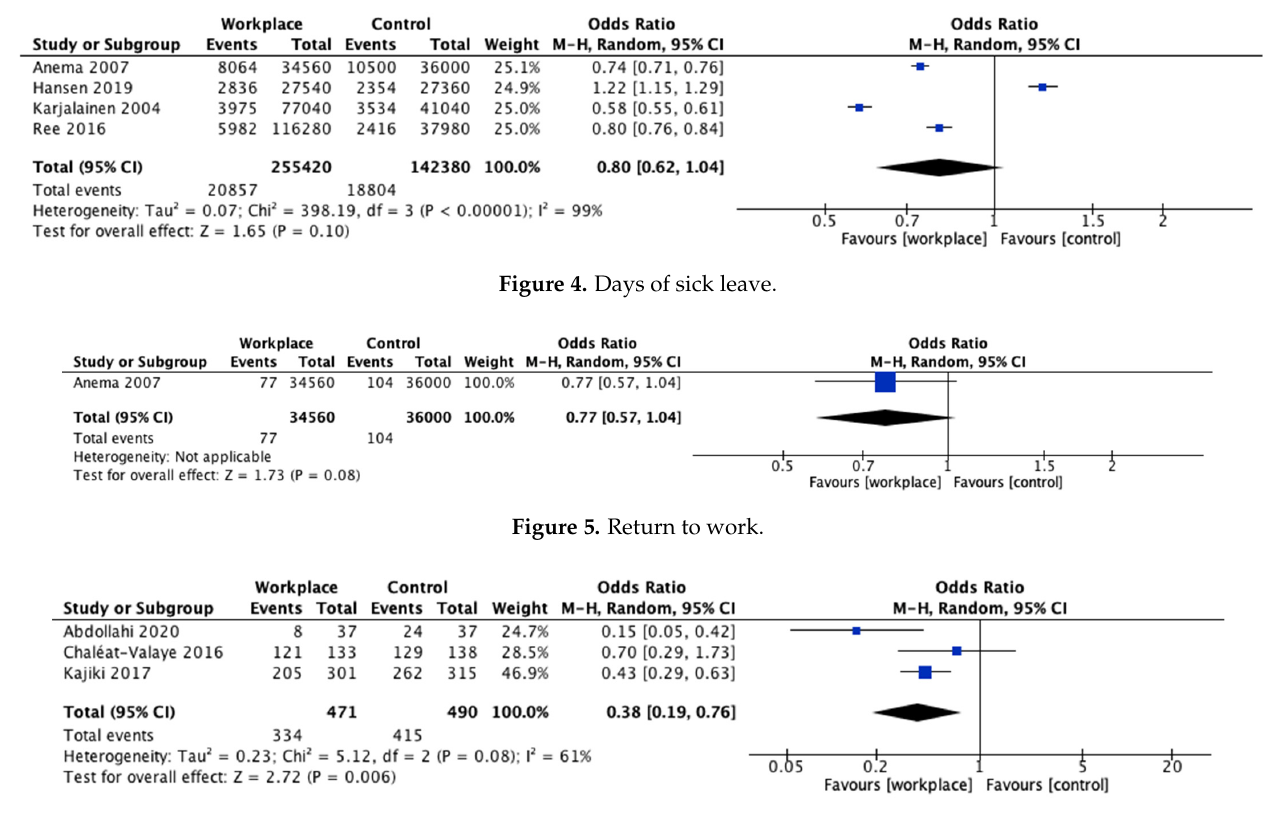
Figure 3. Participants on sick leave.